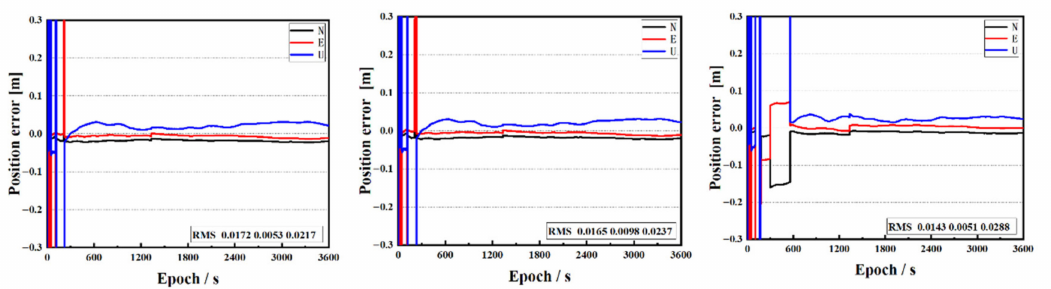
Figure 9. Positioning results of EST60, EST60 × 3 and EST60 ÷ 3.